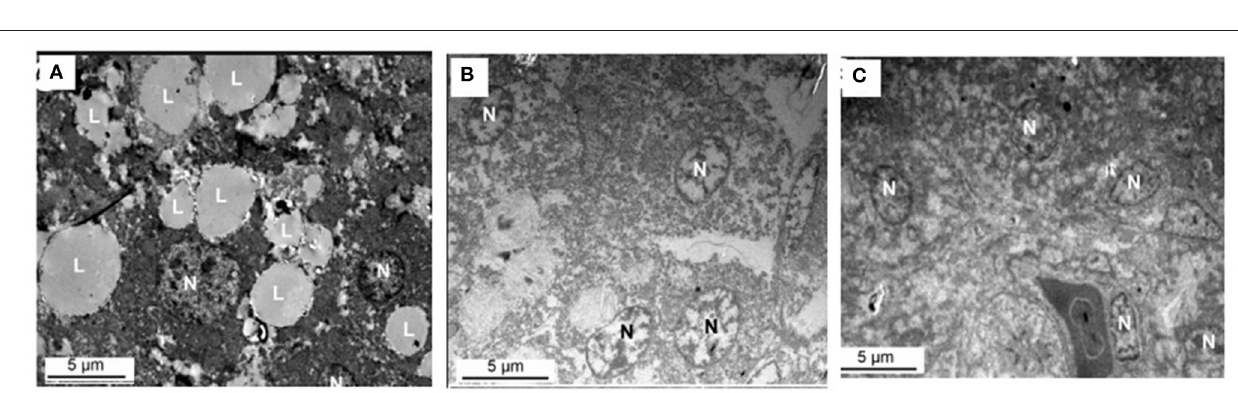
FIGURE 7 | mRNA relative abundance of LPL, PPAR γ , and FAS in abdominal fat of broilers. (A–C) represent the mRNA abundance of LPL, PPAR γ and FAS genes, respectively. The mRNA relative abundance was normalized to those of β -actin gene. Values are means ± SE. Superscripts (a and b) denote significant differences ( P < 0.05).